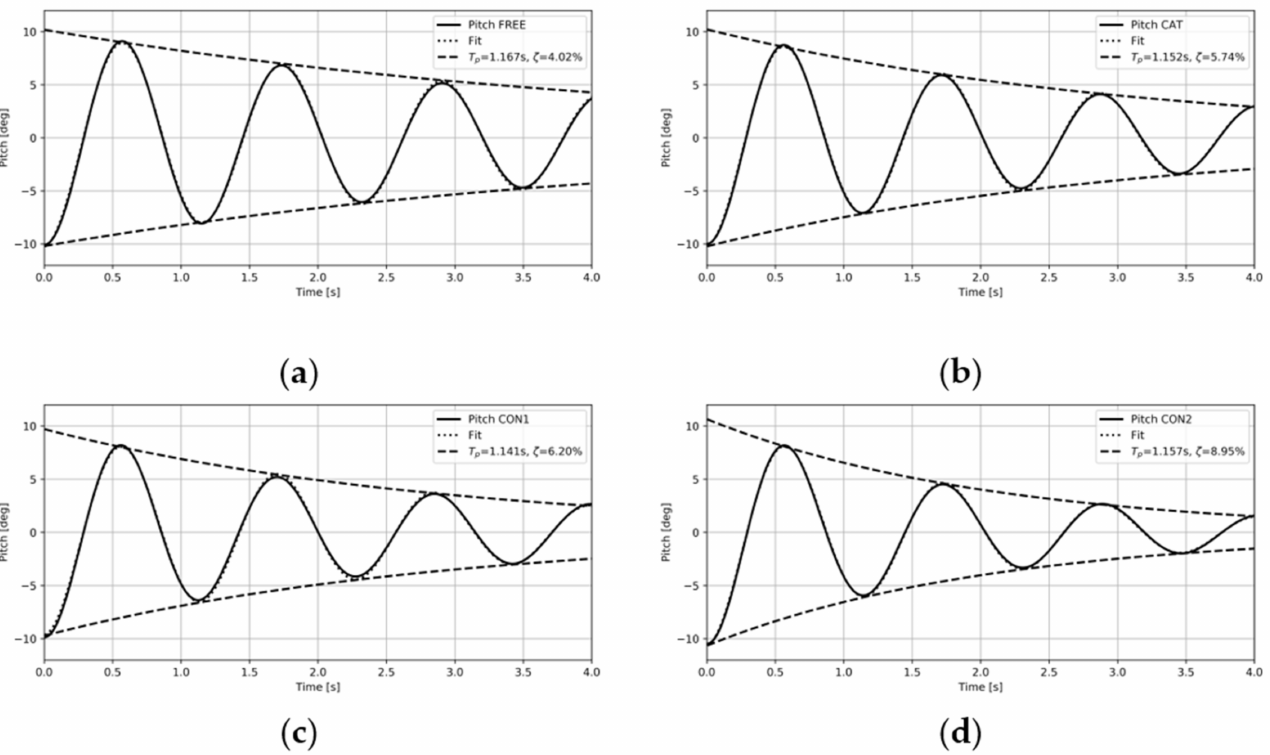
Figure 15. Time series to estimate the natural period and percentage of critical damping for the decaying pitch motion of: ( a ) the free buoy; ( b ) of the buoy with mooring systems CAT; ( c ) CON1, ( d ) and